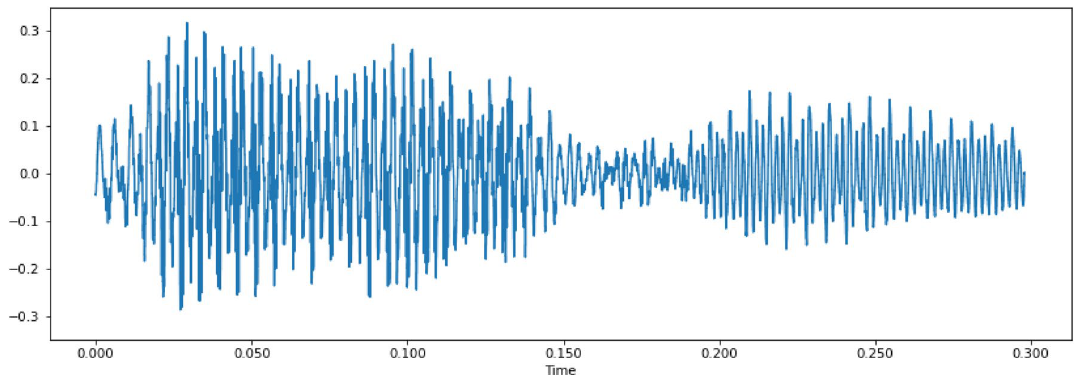
Fig. 4 Waveform of